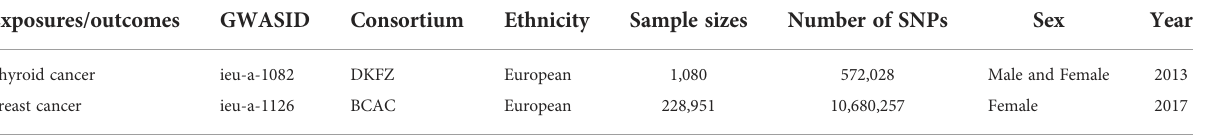
TABLE 1 Summary of the GWAS included in this MR study